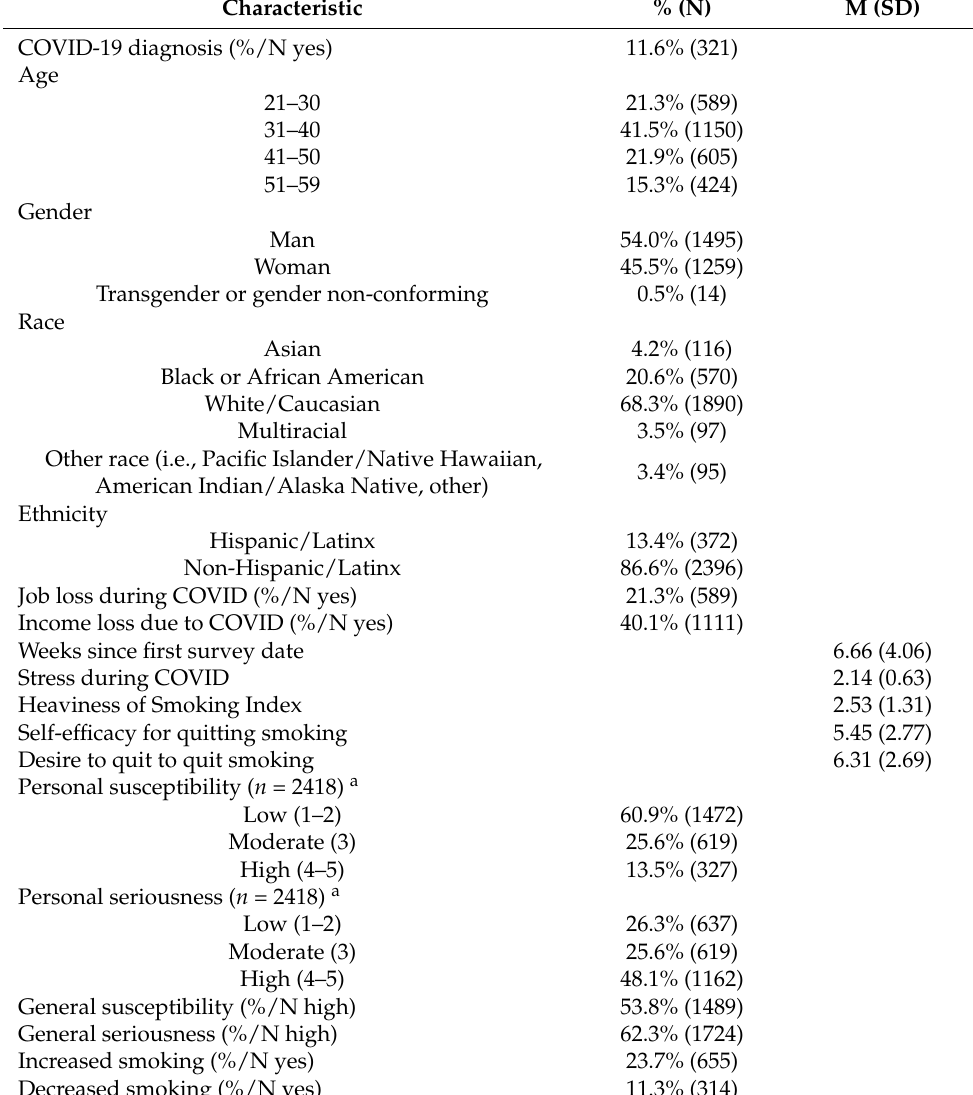
Table 1. Participant characteristics (N = 2768).